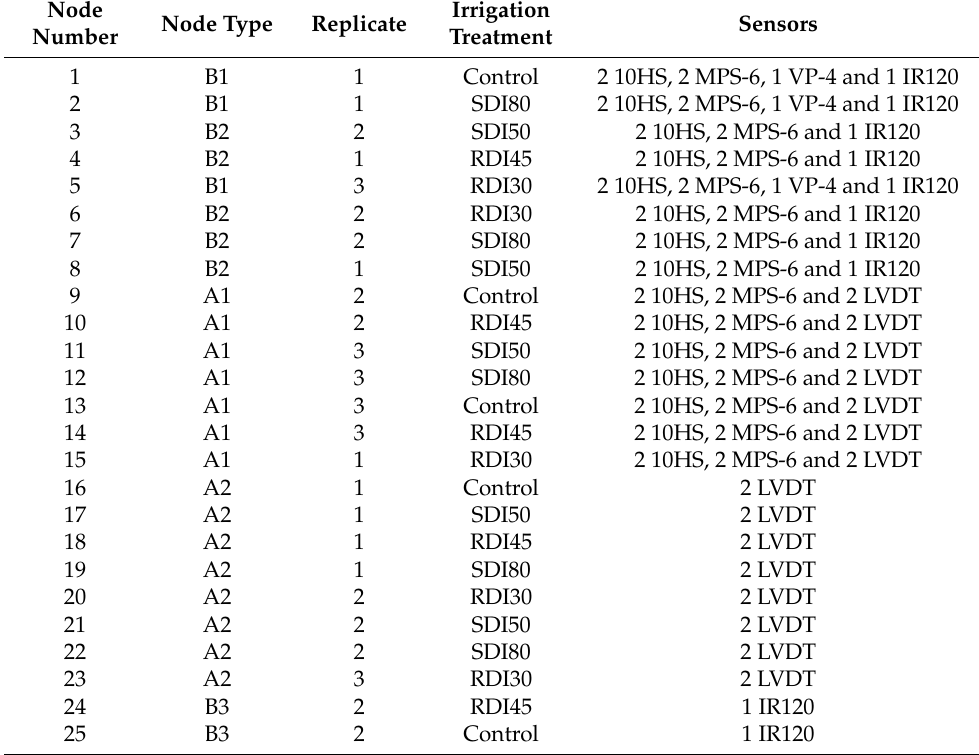
Table 2. Description of the deployed nodes.